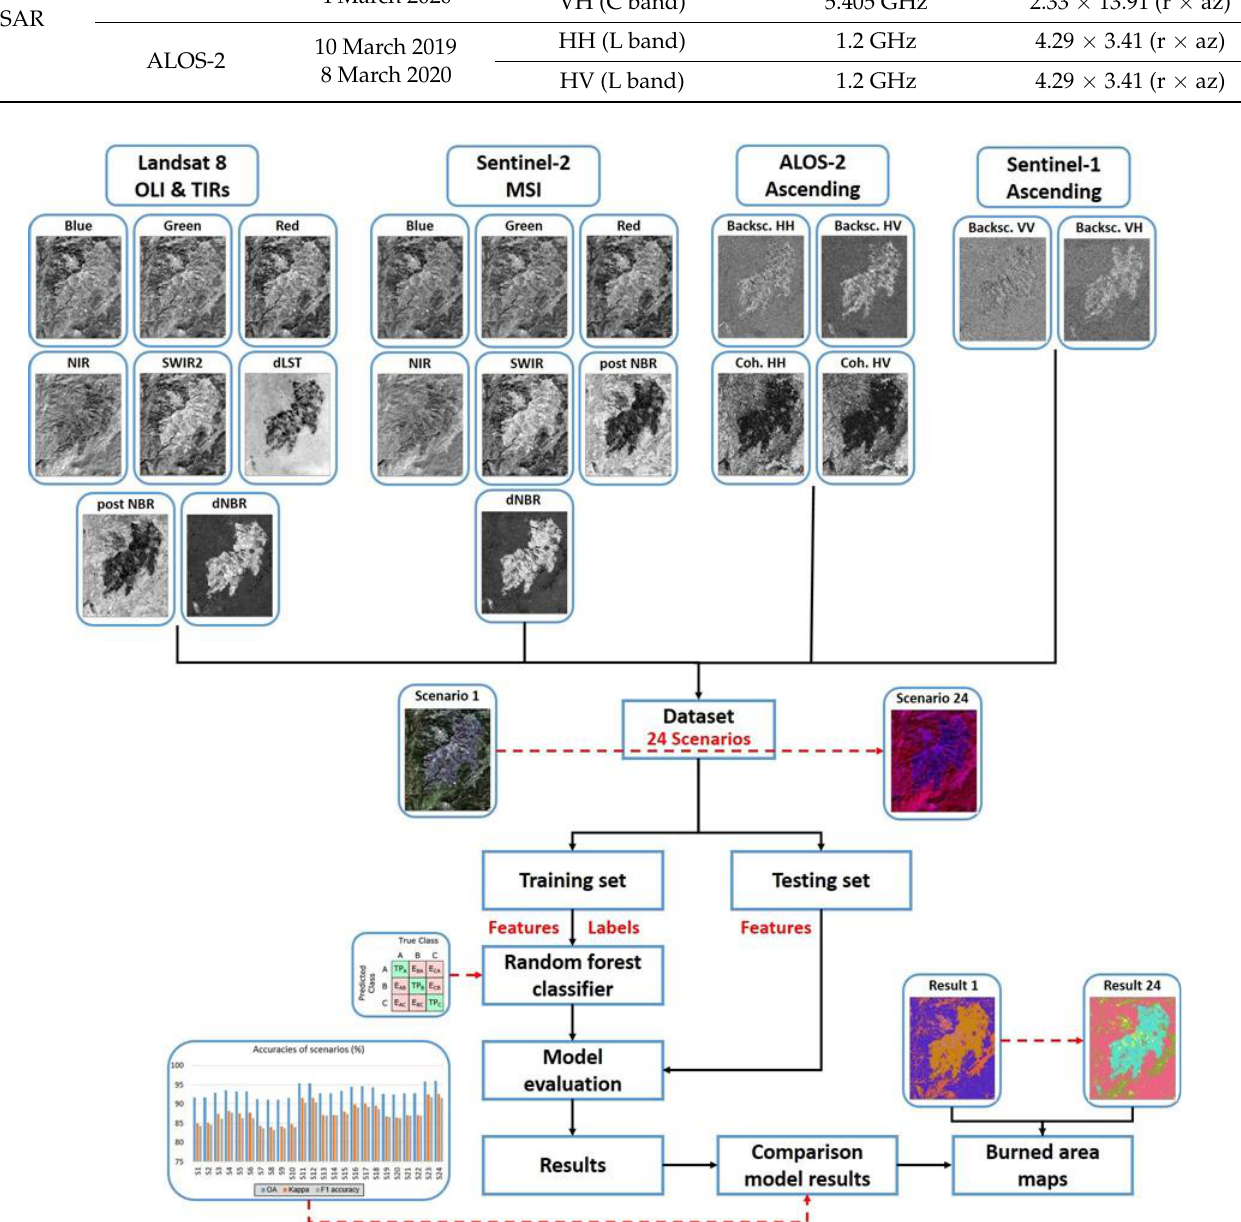
Figure 2. Workflow of the